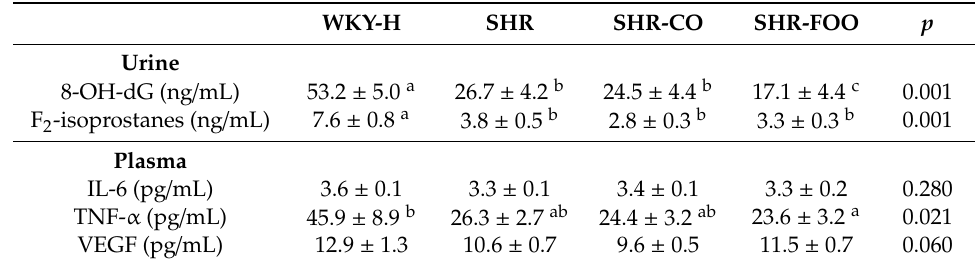
Table 4. Oxidative stress and inflammatory biomarkers after eight weeks of